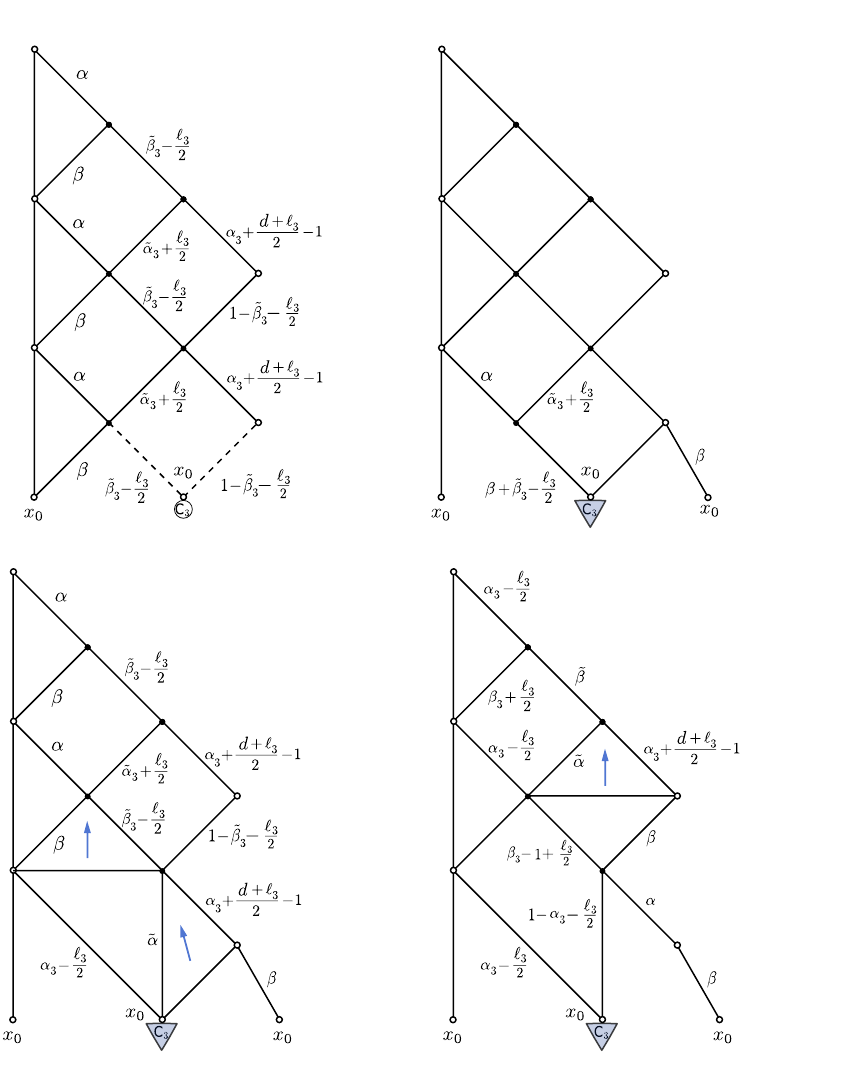
Figure 13 . Top left: action of the transfer matrix Q 3 ( u ) on the layer operator C 3 · Λ 3 ( u 3 ) . Top right: the tensor structure is regarded as the action of a differential operator C 3 ( ∇ x ) as in 0 equation (A.4), and here represented by the blue triangle. The line with power β and extreme x 0 is pulled under the action of the operator C 3 ( ∇ x ) by means of the property (A.5). In the bottom 0 drawings, lines are moved via several star-triangle and chain-rule identities, illustrated via arrows (see, for details, appendix